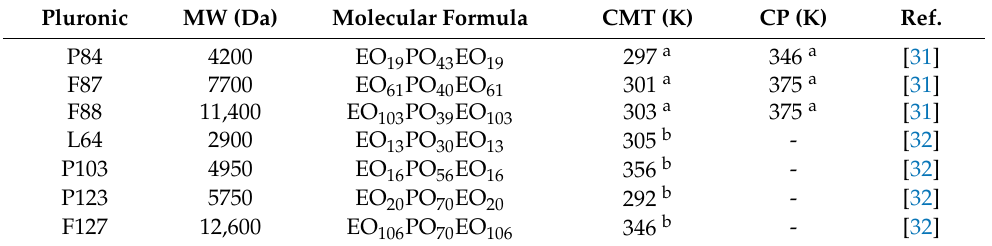
Figure 2. Pluronic grid including CMC values at 37 °C. Adapted from [29,30] with permission from the Royal Society of Chemistry. Table 1. Selected examples illustrating the impact of the polymer structure on the CMT and CP.